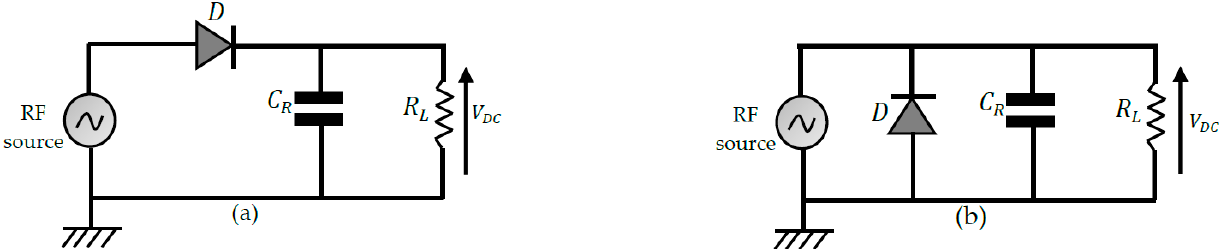
Figure 9. Half-wave rectifier topologies. ( a ) SSD. ( b ). SPD.